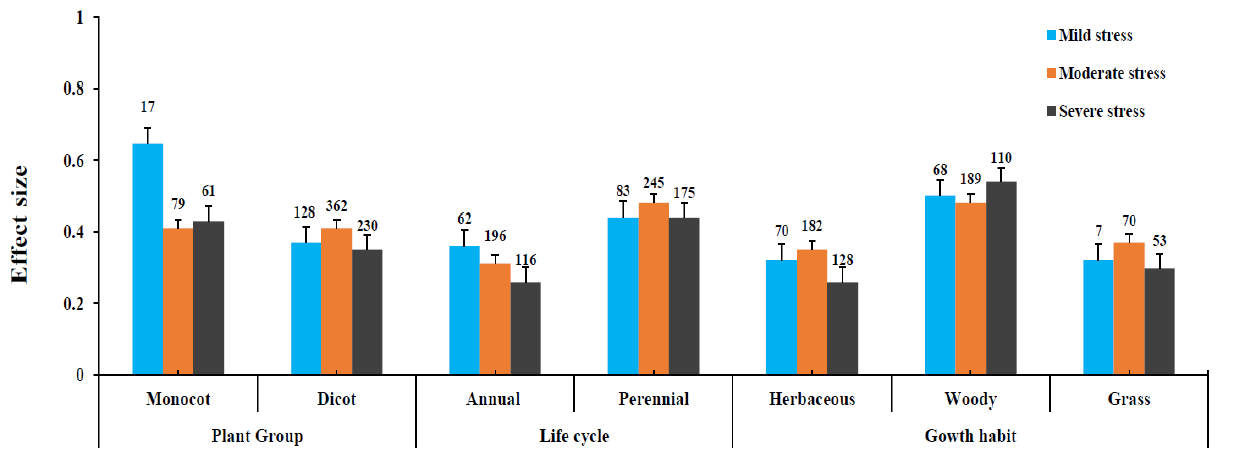
Figure 4. Categorical analysis of plant group, life cycle, and growth habit under different levels of stress.